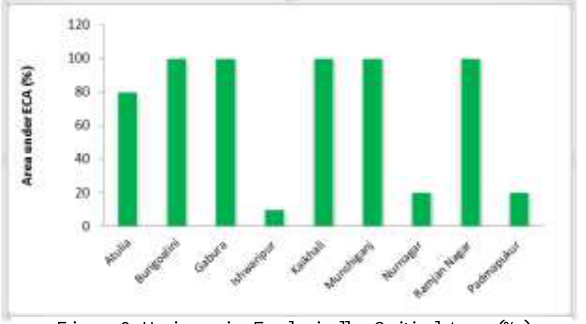
Figure 9. Union-wise Ecologically Critical Area (%)